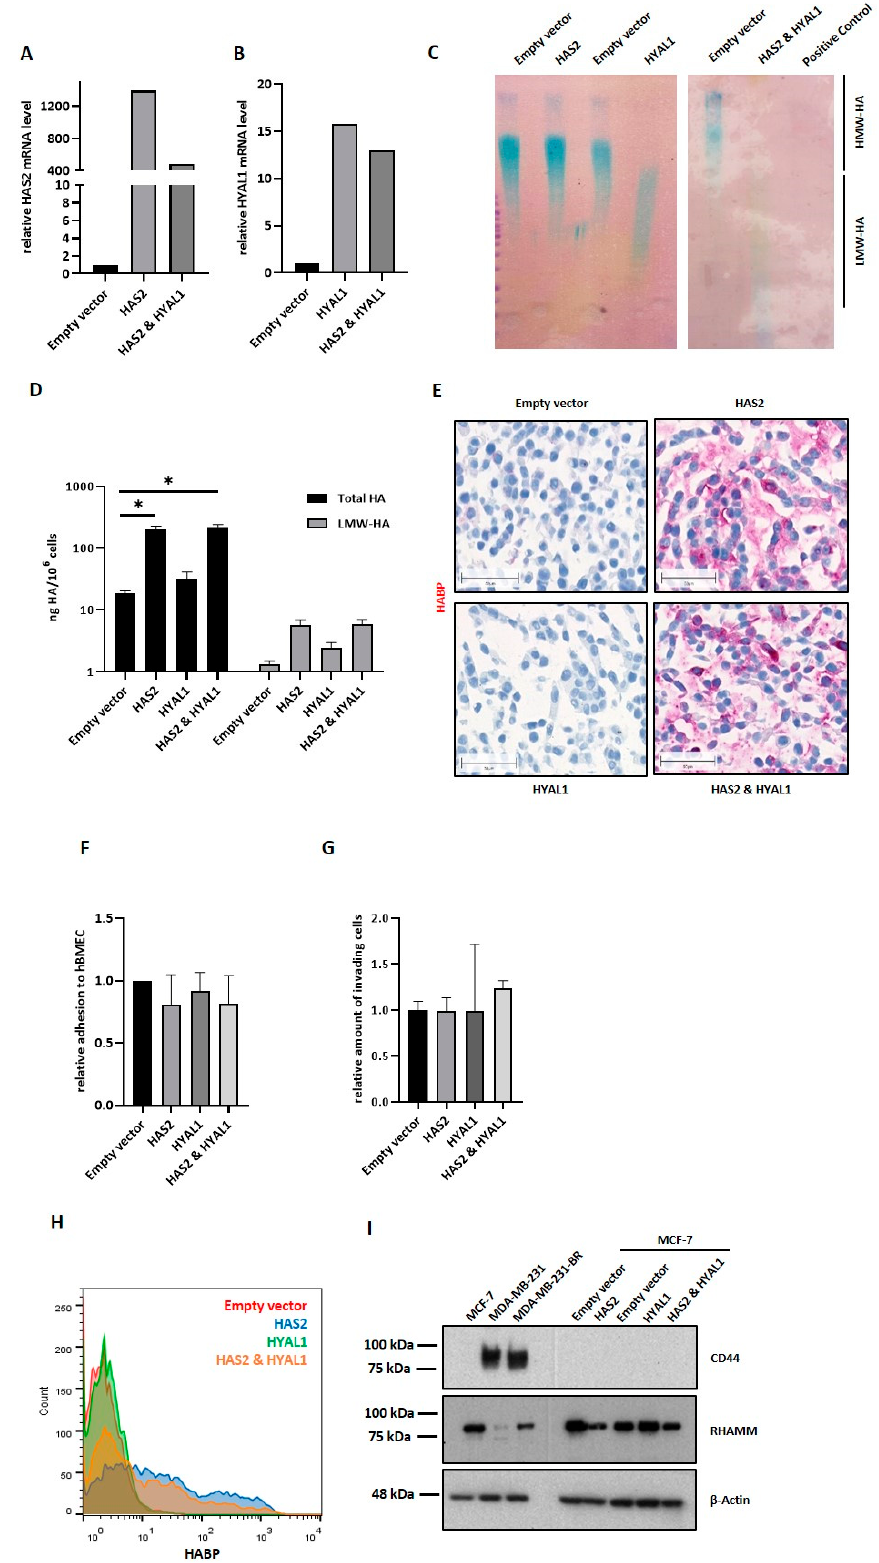
Figure 6. Impact of the HAS2/HYAL1 overexpression in MCF-7 cells on the interaction with the brain endothelium. Relative mRNA level of HAS2 ( A ) and HYAL1 ( B ) in MCF-7 control (empty vector), single overexpression (HAS2 or HYAL1), and double overexpression (HAS2 and